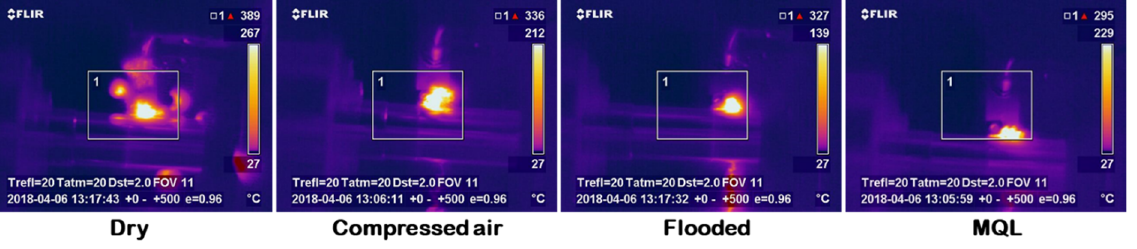
methods at v = 51 m/min, f = 0.12 mm/rev.